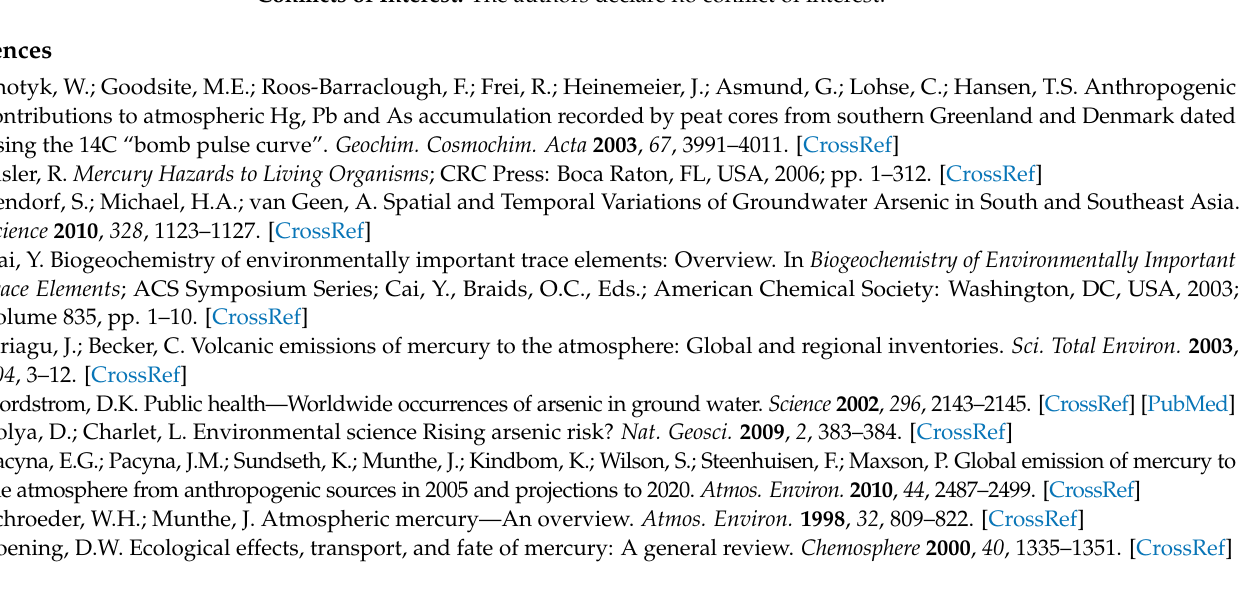
Figure S2. Main trace metal elements concentrations and dry bulk density along peat profile;